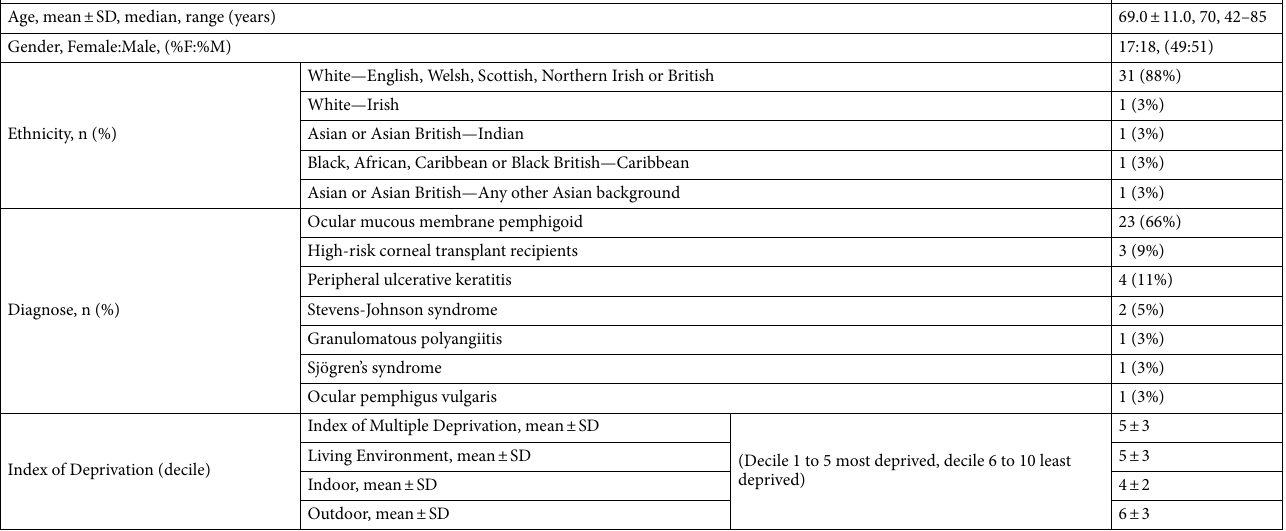
Table 1. Demographics of the subjects included in the study.